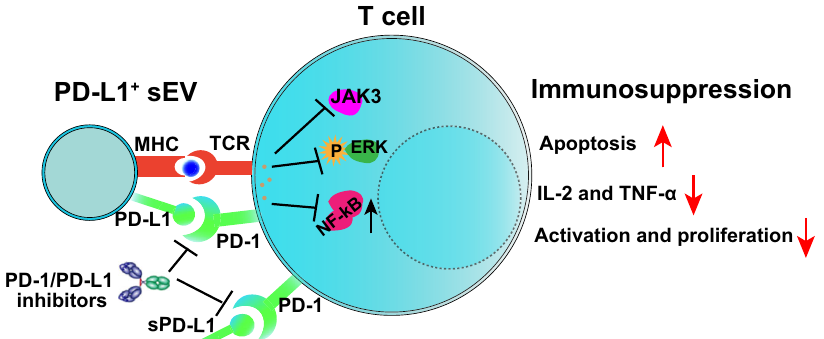
Fig. 4 The immunosuppressive effects of sEV PD-L1. sEV PD-L1 acts as second signal and exerts inhibitor signals on T cells through PD-1, which promoted the apoptosis of T cells and suppressed the activation and production of